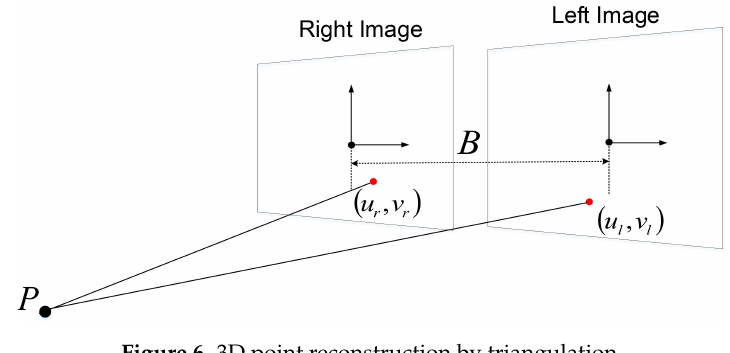
Figure 6. 3D point reconstruction by